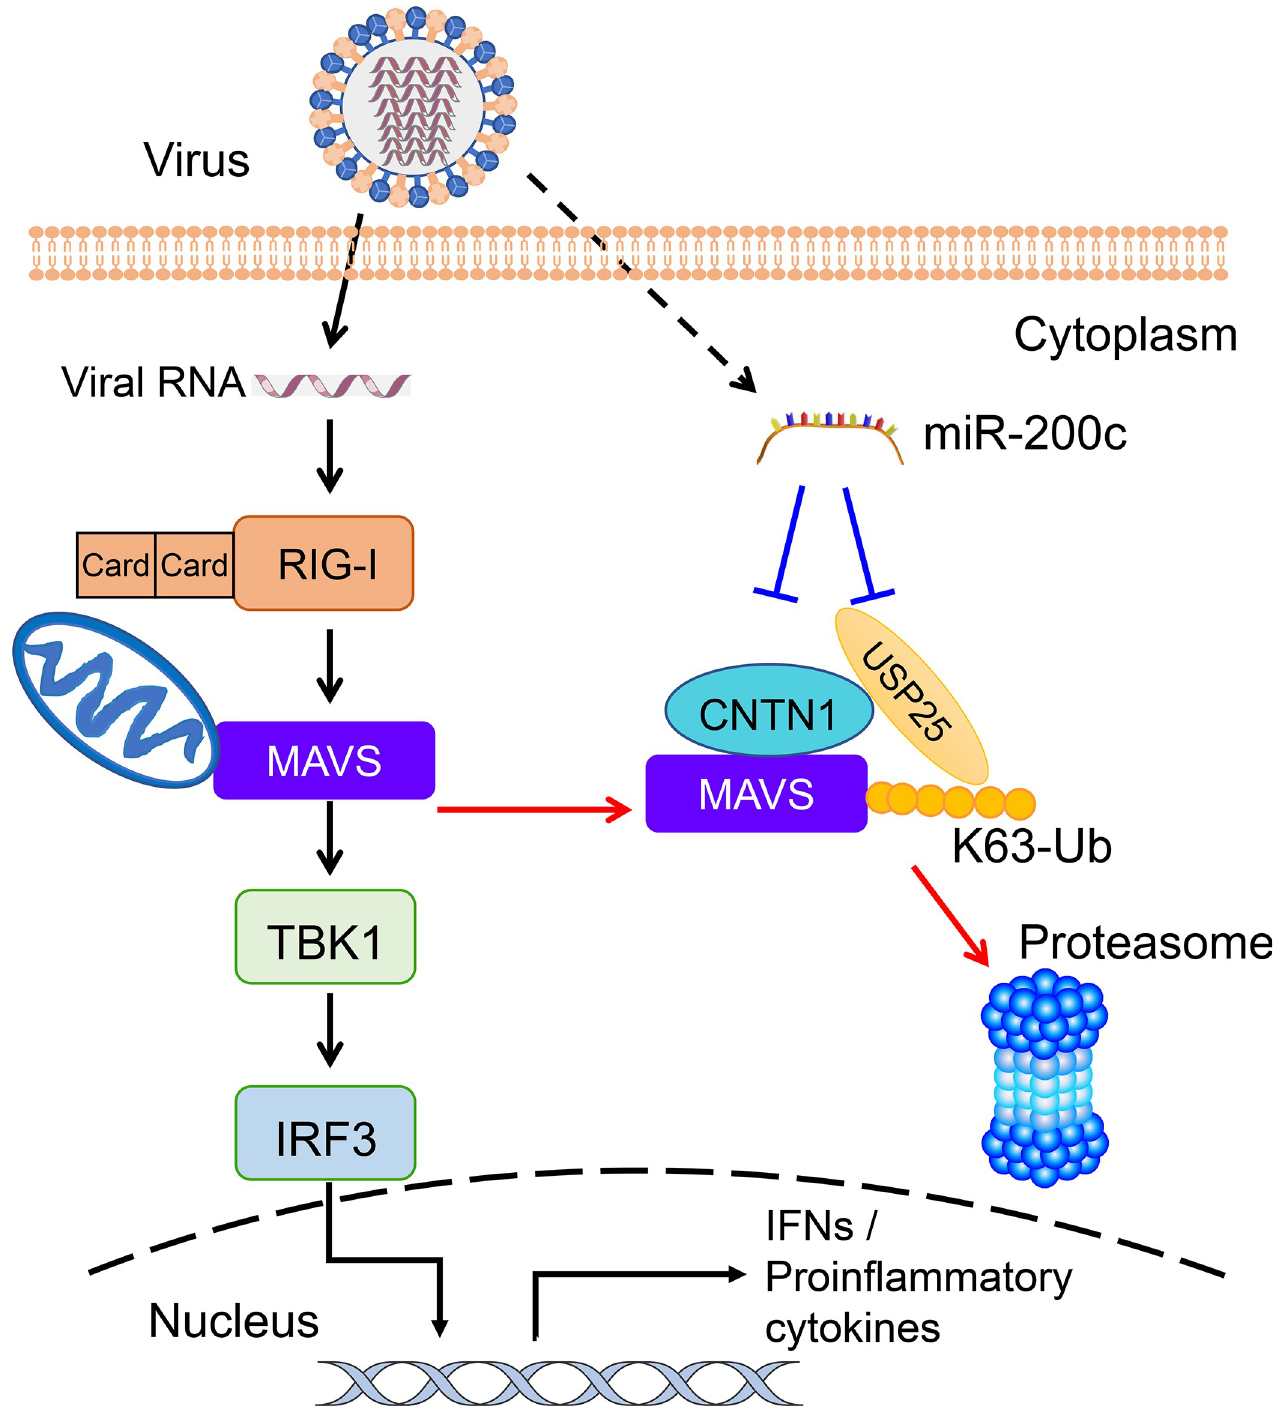
Fig 8. A working model of the role of CNTN1 in the regulation of MAVS-mediated signaling and influenza A virus replication. Black arrows indicate the RIG-I/MAVS-mediated type I IFN signaling pathway. The dotted line indicates the induction of miR-200c following virus infection. The blue lines indicate the interaction between miR-200c and CNTN1/USP25. The red arrows indicate the process of CNTN1-mediated proteasomal degradation of MAVS.